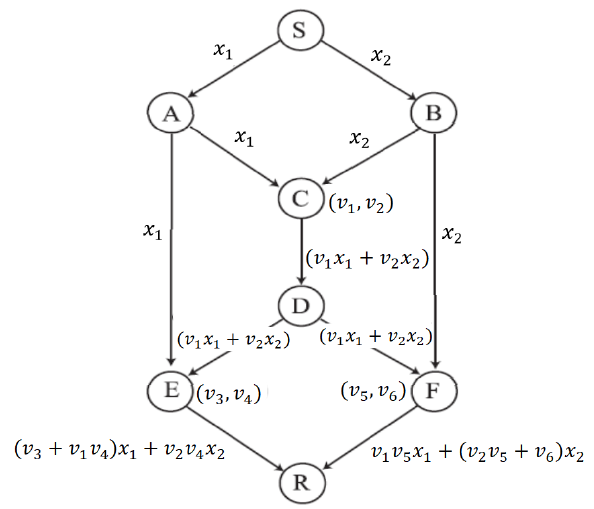
Figure 2. An example of linear network